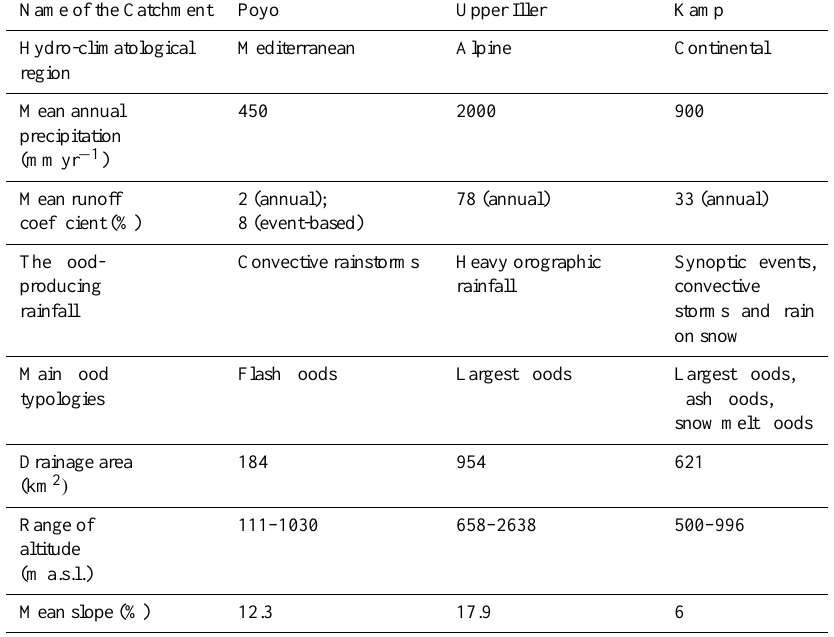
Table 1. Main characteristics of the study areas.